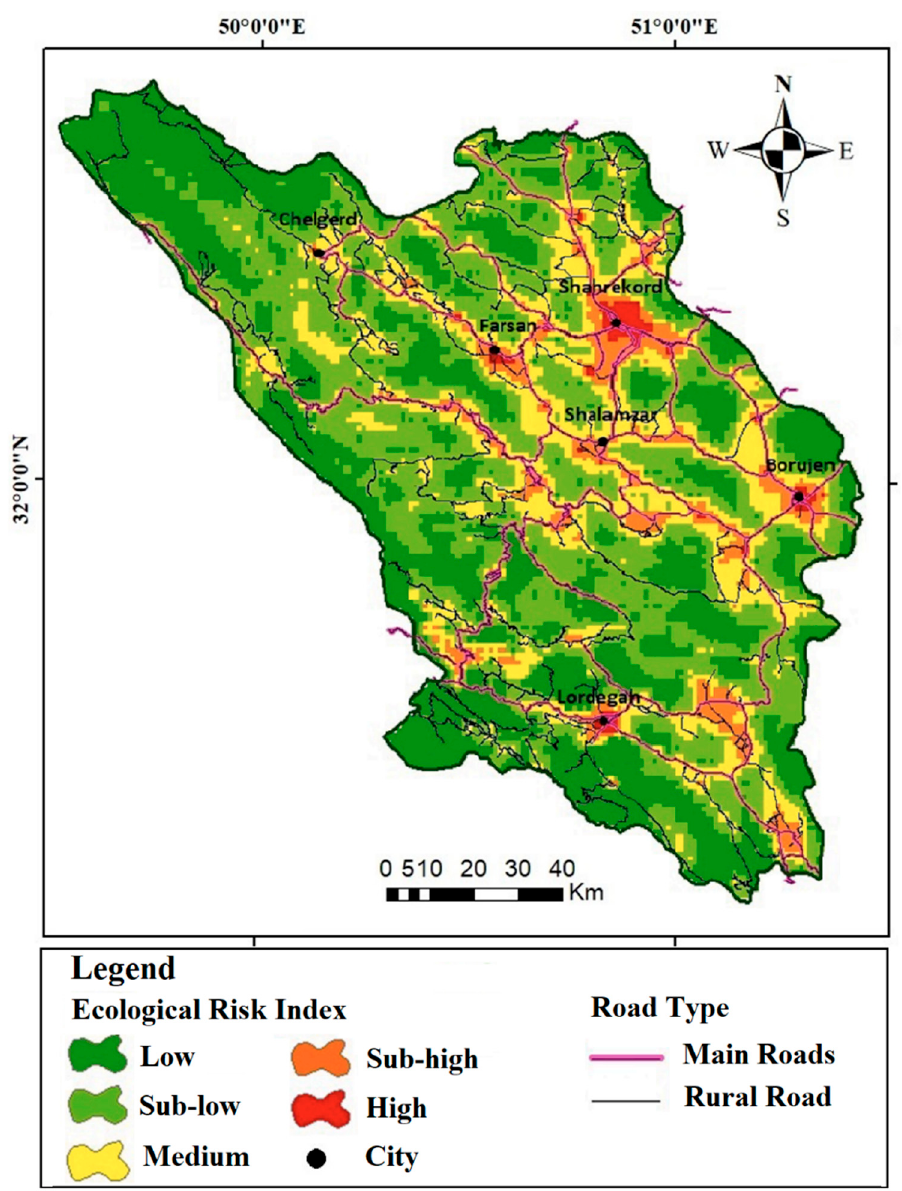
Figure 7. The final classification map of the landscape index of ecological risk (ERI).